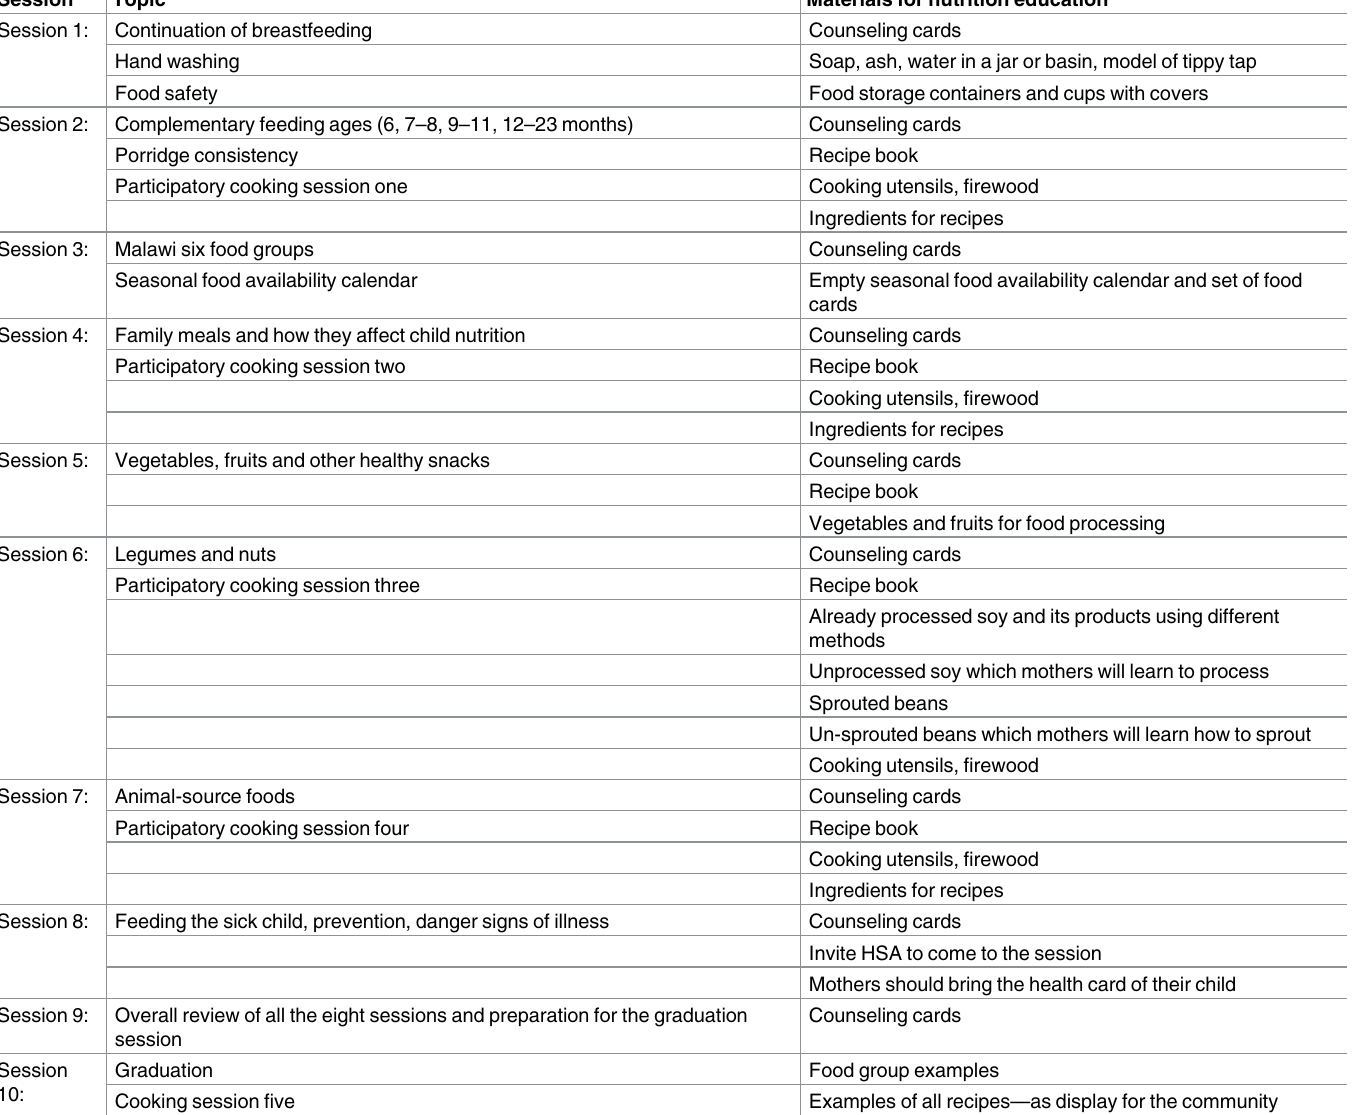
Table 1. Content of nutrition education (FAO